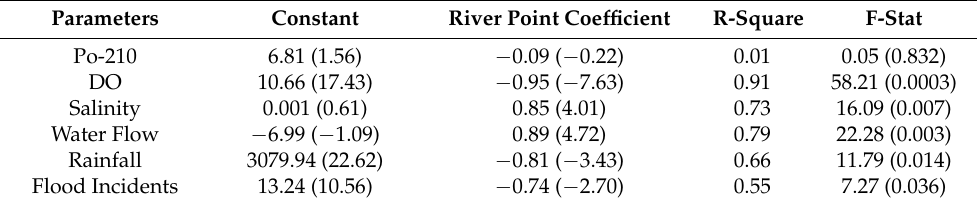
Table 4. Results of the Linear Regression-based Trend line of Po-210, Physiochemical and Environmental